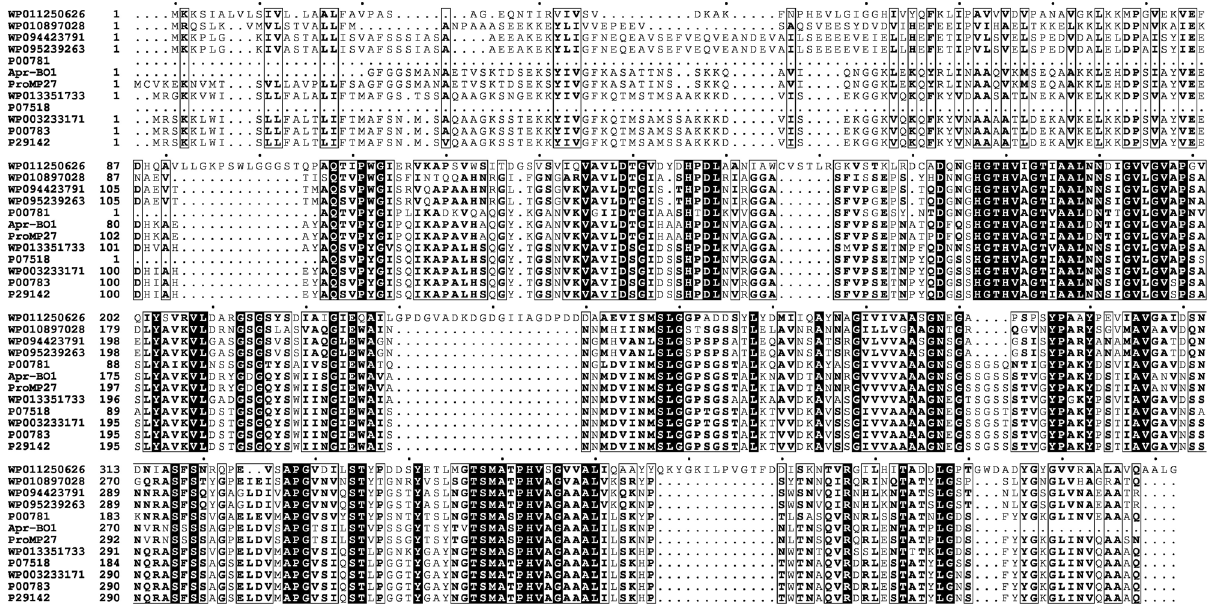
Figure 4. Analysis of amino acid sequences by multiple alignments using homologous proteases. The residues highlighted by the black background are strictly conserved, and those boxed are conservatively substituted. The figure was produced using ESPript 3.0 program 88